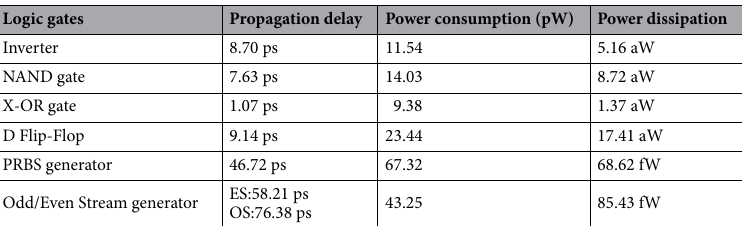
Table 4. Circuit level performance